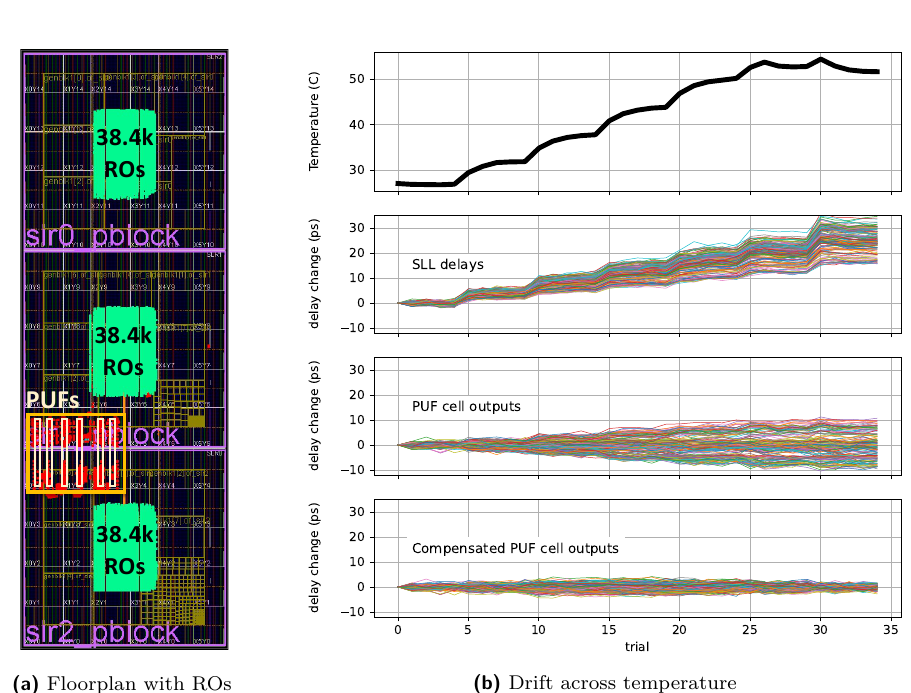
Figure 10: Performance across temperature. (a) shows the PUF design instantiated together with 38,400 ROs on each SLR used to create heating. (b) shows how the SLL delays and the PUF outputs change across the trials as the chip heats